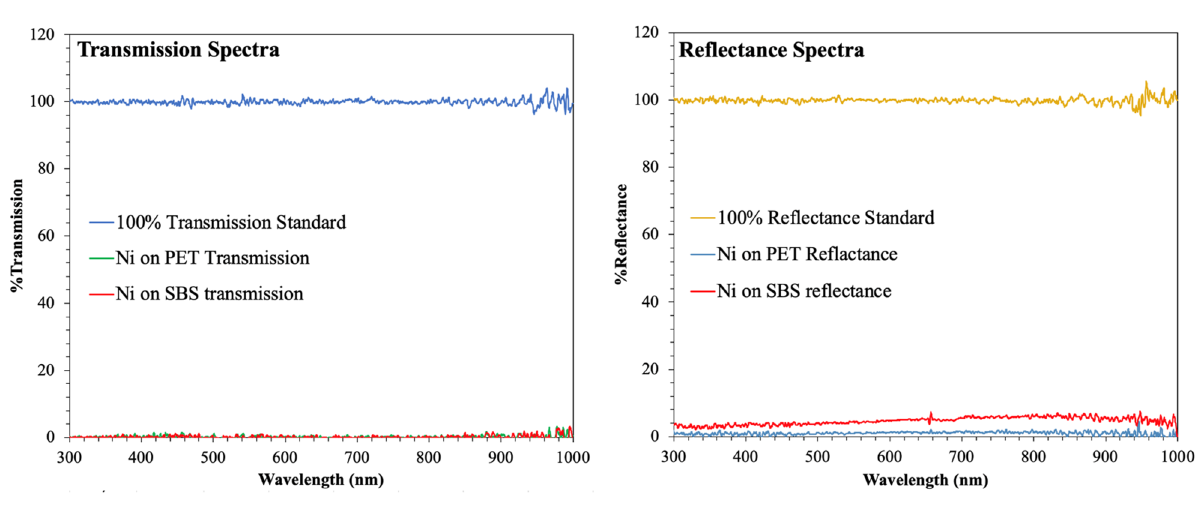
Figure 11. Optical property of printed Ni ink. Factors